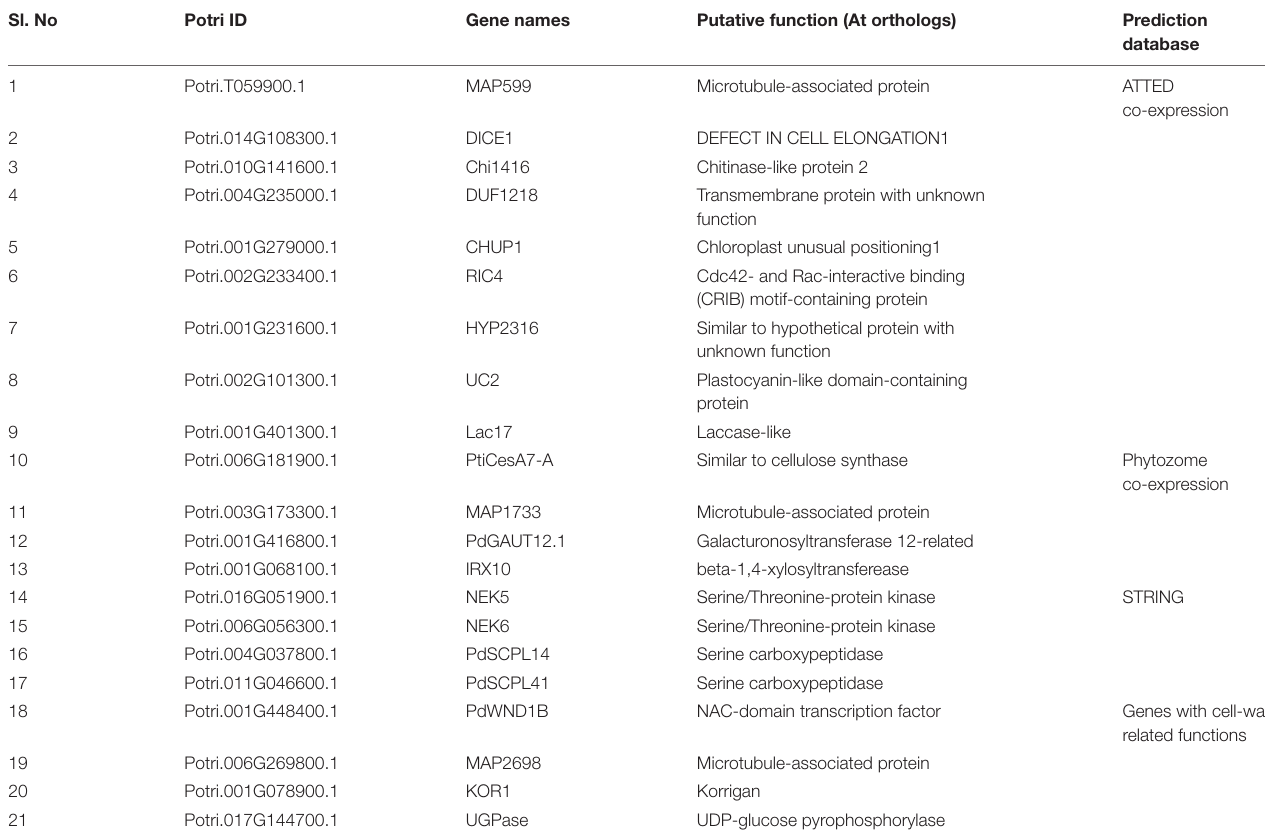
TABLE 3 | List of putative interacting partners tested. Sl.